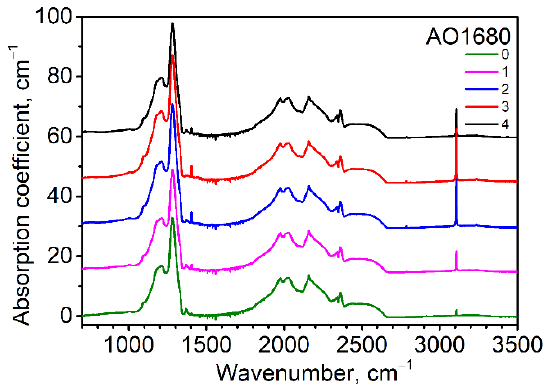
Figure 2. Infrared (IR) spectra corresponding to point positions given in Figure 1 for the AO1680 diamond sample (plate) from the Mir deposit. The spectra were shifted for clarity. The 2340–2360 cm −1 feature is a CO 2 artifact.